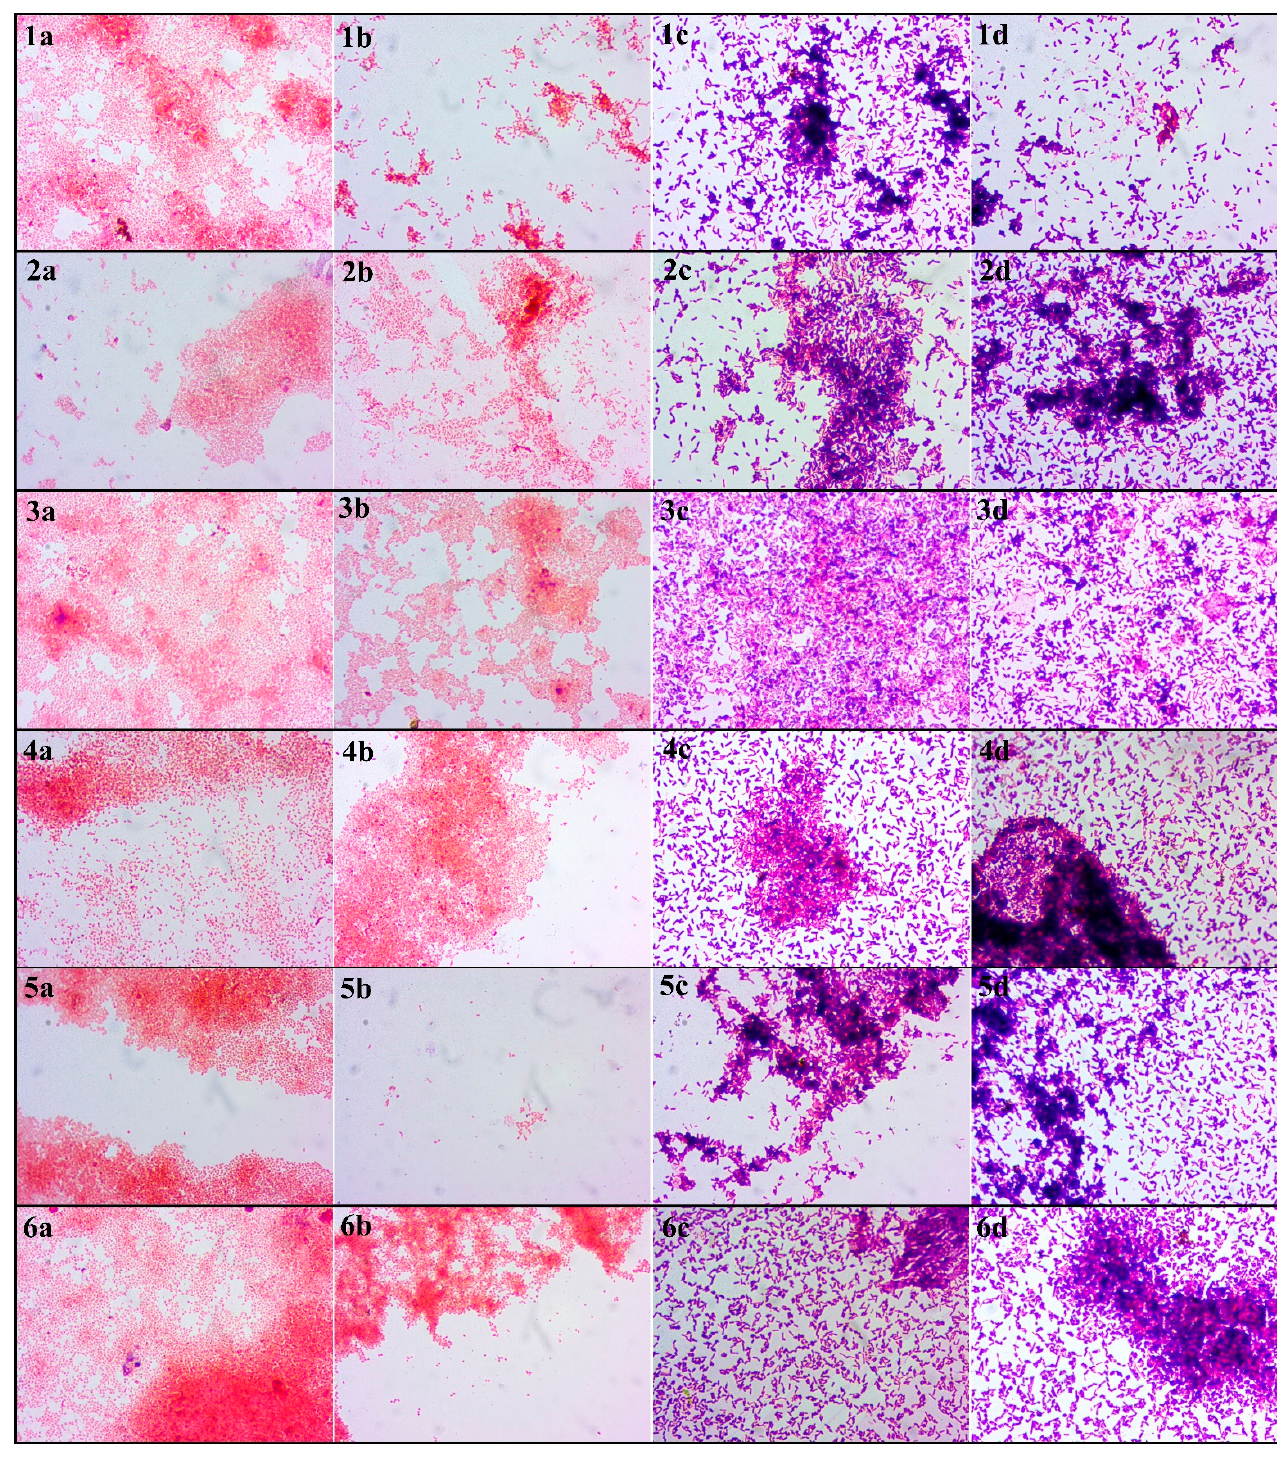
Figure 5. Light microscopy micrographs of biofilms formed during mung bean germination. Explanations: The numbers ( 1 , 2 , 3 , 4 , 5 , 6 ) refer to the strain. ( 1 )— E. coli ATCC 10536; ( 2 )— E.coli ATCC 25922; ( 3 )— E. coli O157:H7; ( 4 )— S. enteritadis ATCC 13076; ( 5 )— S. enteritadis ATCC 29631; ( 6 )— S. hofit IFM 2318. The letters ( a , b , c , d ) refer to the disinfection method. ( a )—D1 disinfected with the 1st method; ( b )—D2 disinfected with the 2nd method; ( c )—DP1 disinfected with the 1st method + L. plantarum 299v; ( d )—DP2 disinfected with the 2nd method + L. plantarum 299v; Bacteria were observed at 1000× magnification.